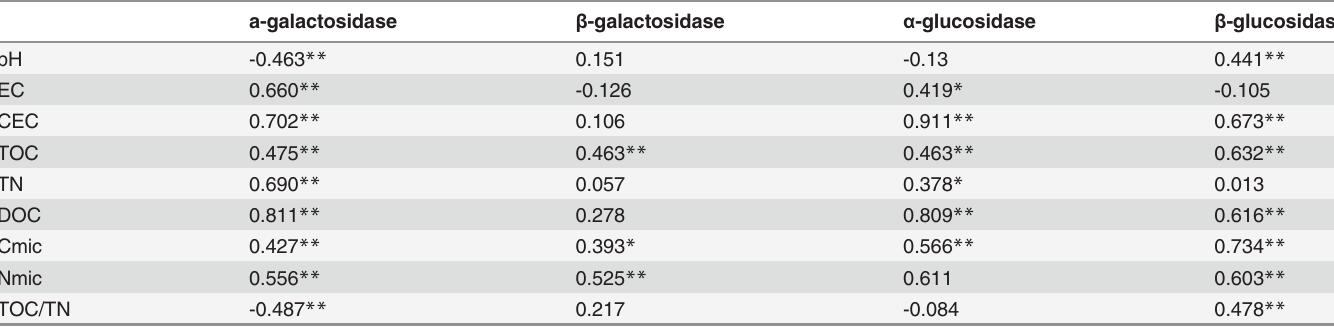
Table 3. Correlation analysis between soil enzyme activities and soil physical-chemical characteristics.